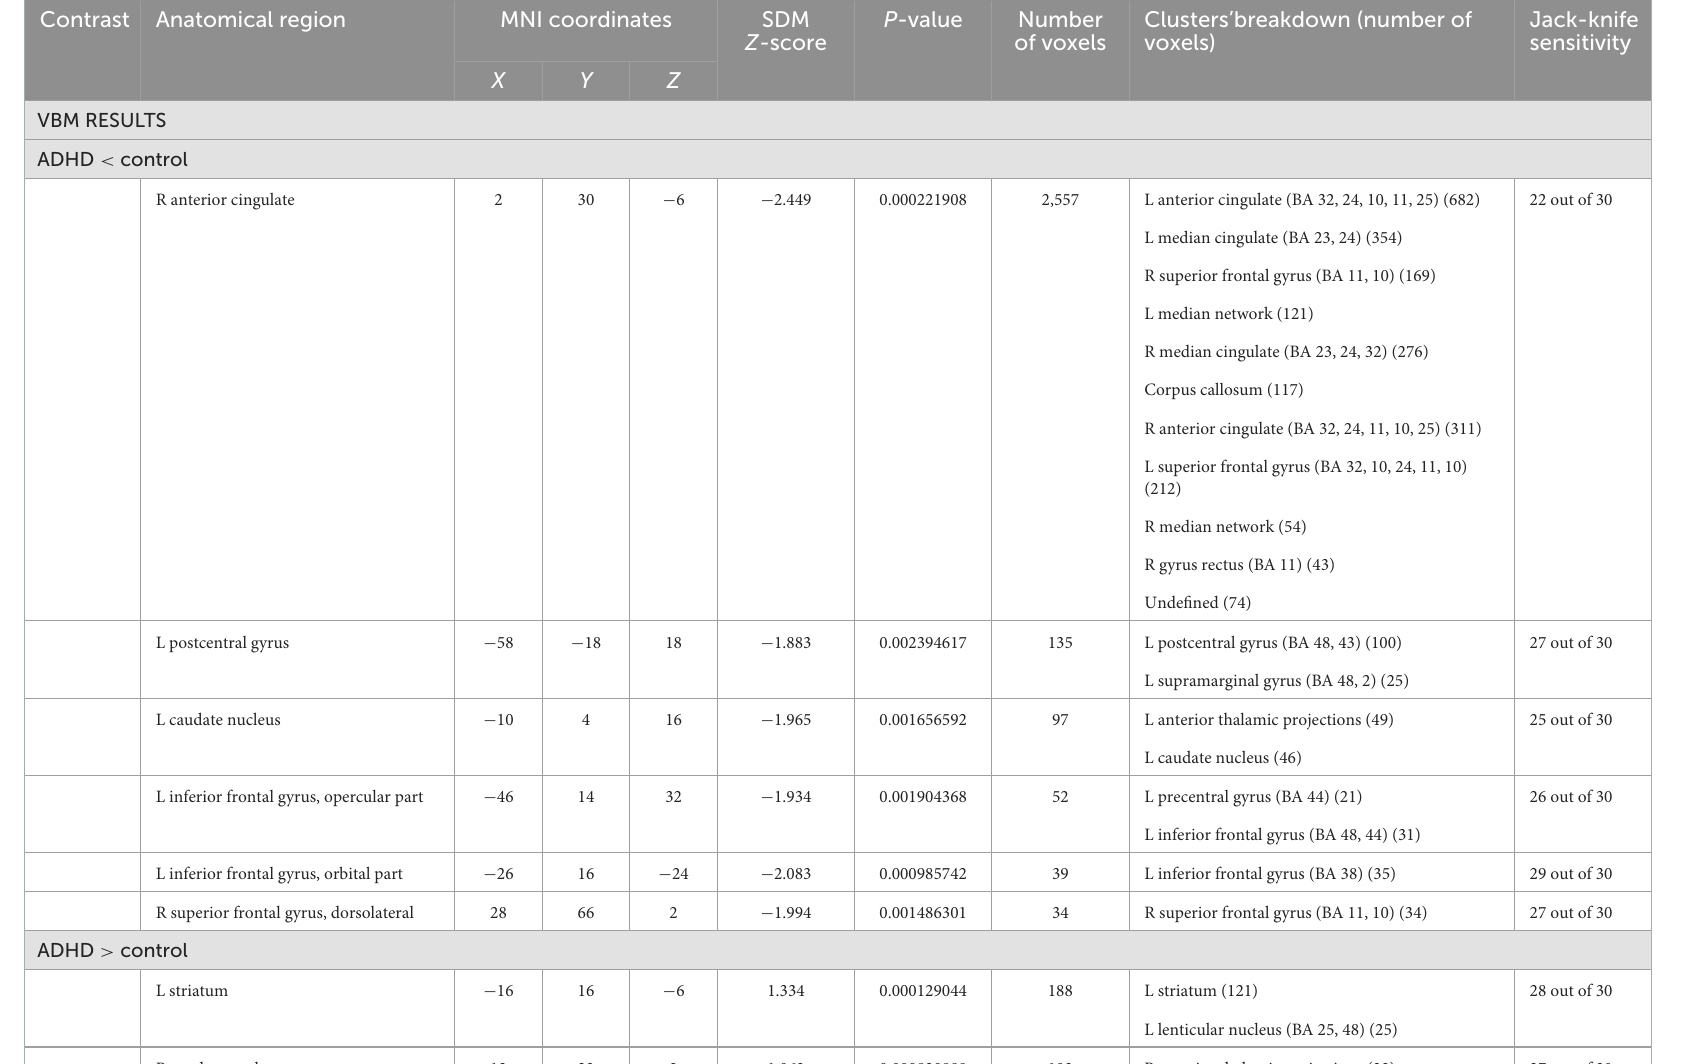
TABLE 3 Meta-analysis results for voxel-based morphometry and fMRI studies in ADHD. Contrast Anatomical region MNI coordinates SDM